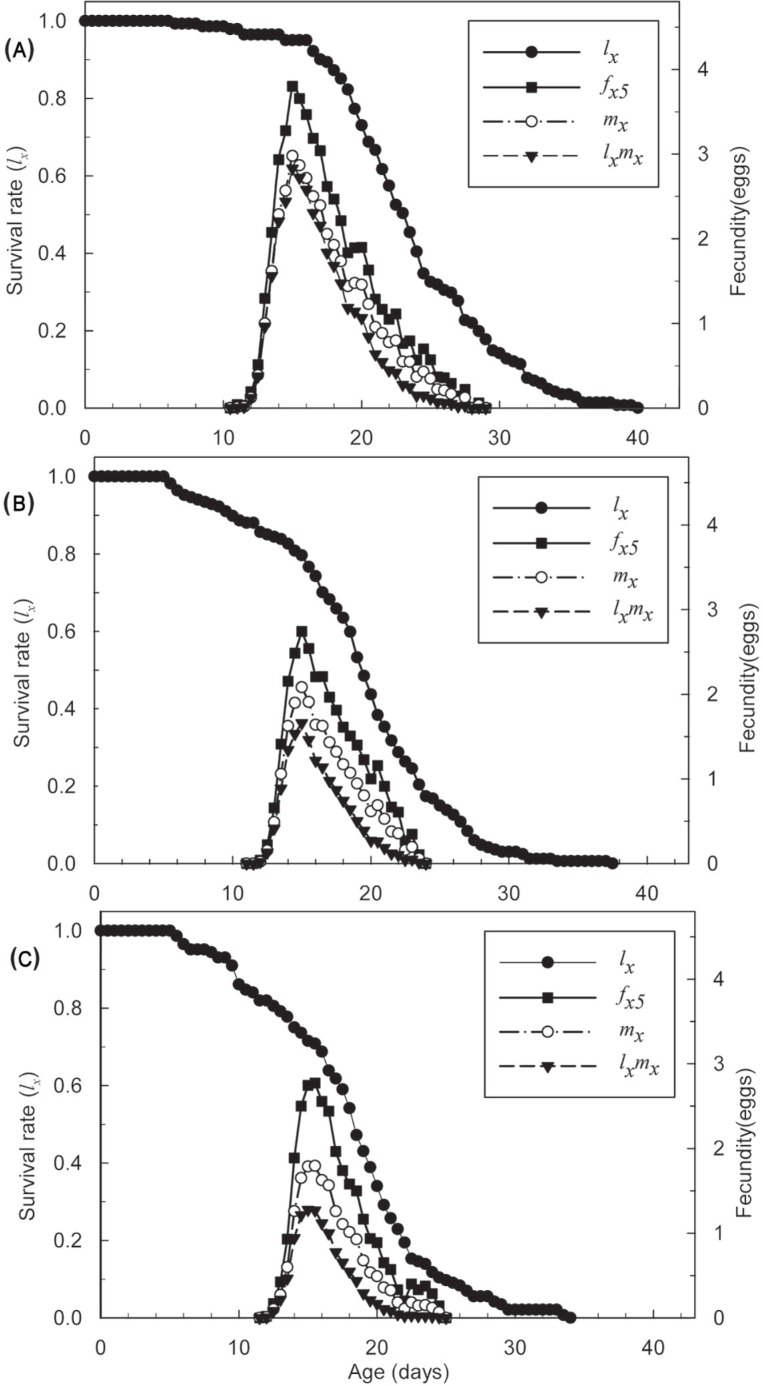
Age-specific survival rate (lx), female age-specific fecundity (fx5), age-specific fecundity of the total population (mx), and age-specific maternity (lxmx) of T. cinnabarinus eggs treated with sublethal concentrations of SYP-9625.(A) Control, (B) LC10, (C) LC30.